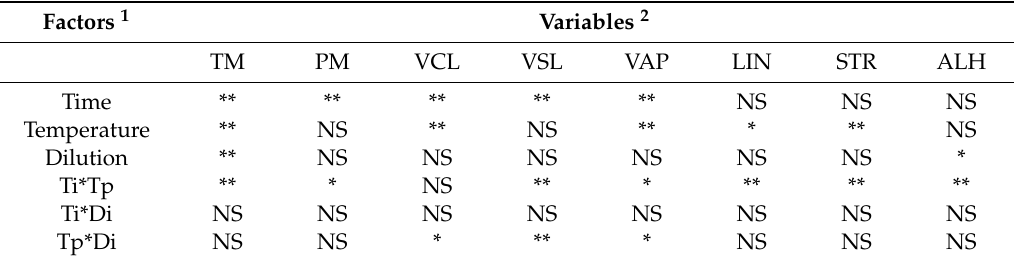
Table 1. Significance levels of factors for variables studied in Experiment 1.